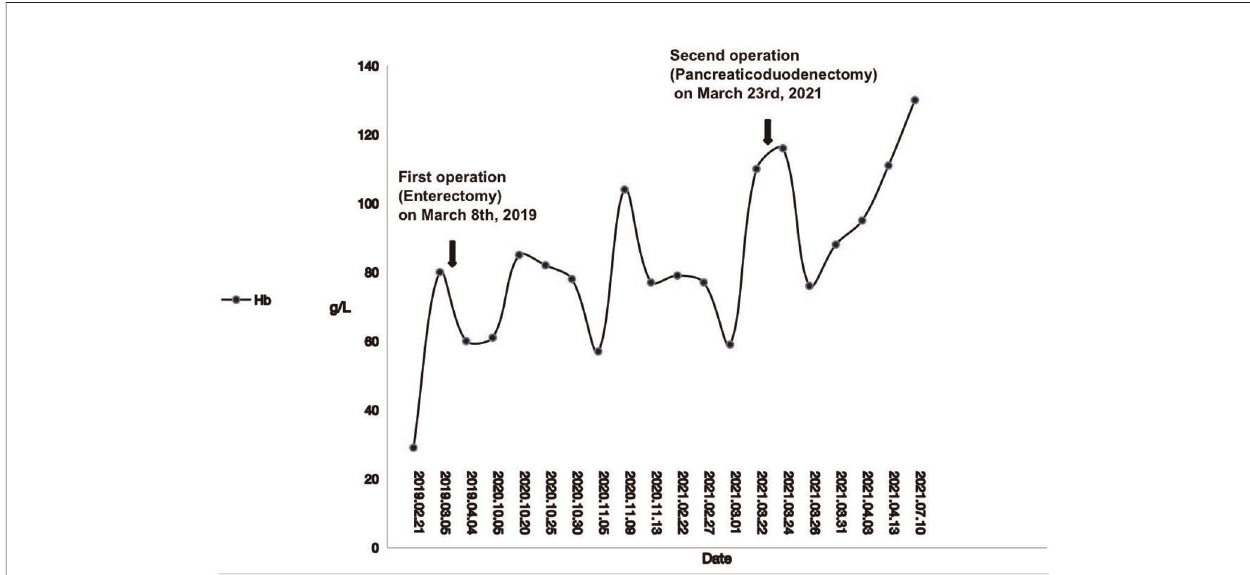
FIGURE 1 | Changes in hemoglobin values between two surgeries (February 2, 2019 to July 10,